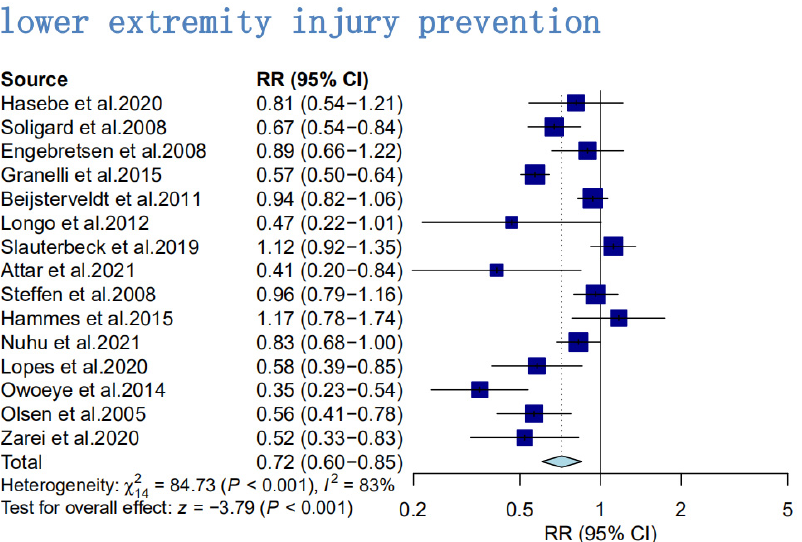
Figure 3. Funnel plot based on study standard error and risk ratio in assessing publication bias.